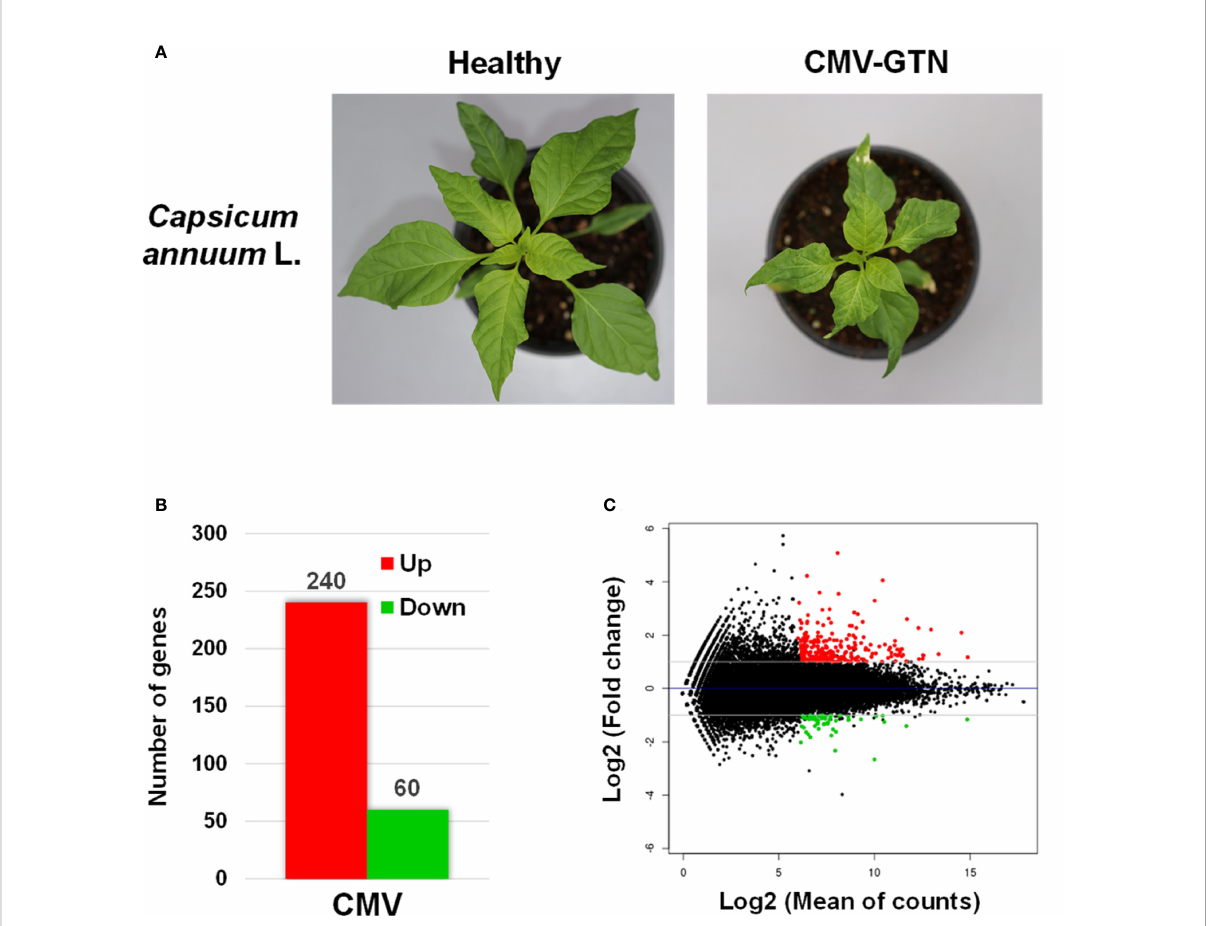
FIGURE 2 Transcriptomic reprogramming of pepper upon infection with CMV. (A) Phenotypes of healthy and CMV-infected pepper plants ( Capsicum annuum L.) subjected to transcriptome analysis. Plants infected with CMV-GTN exhibited mosaic, severe leaf size reduction, and stunted growth. (B) Number of differentially expressed genes (DEGs) identi fi ed using RNA-seq of CMV-infected pepper plants. The DEGs were identi fi ed by comparing the transcriptomes of CMV-infected and healthy pepper plants (two-fold change in expression with a false discovery rate of ≤ 0.01). Red and green bar indicates the number of up- and downregulated DEGs, respectively. (C) MA-plot of RNA seq results. Each dot represents one gene. The normalized mean of read counts is shown on the x axis, and the log2 fold change of normalized counts is shown on the y axis. Up- and downregulated DEGs are represented by red and green dots,